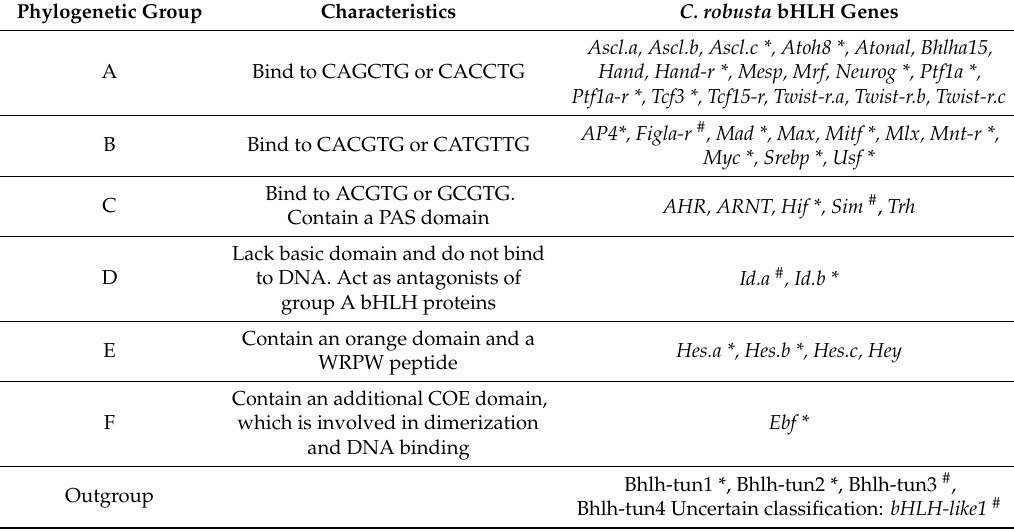
Table 2. Classification of bHLH genes in the ascidian Ciona robusta. Modified from [147,148]. Phylogenetic Group